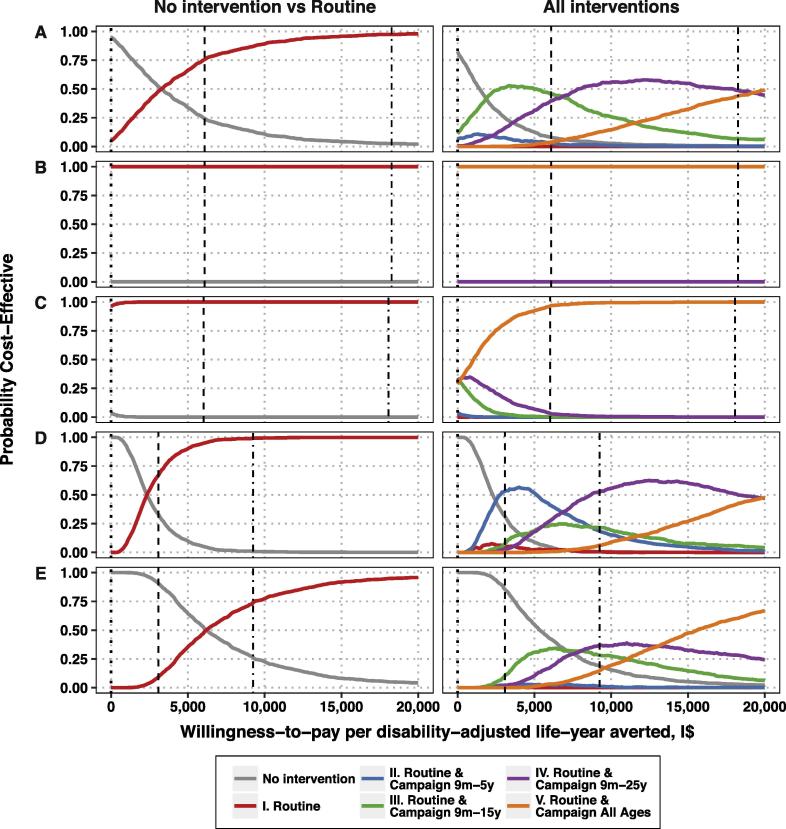
Cost-effectiveness acceptability curves for routine vaccination at 9 months of age (left) and for all five delivery strategies under consideration (right) versus no intervention for (A) Kolkata, (B) Delhi, (C) Dong Thap, (D) Nairobi, and (E) Lwak. The dotted line shows the threshold at which an intervention is considered cost-saving, while the dashed line delineates the threshold at which an intervention is considered very cost-effective and the dot-dashed line delineates the threshold at which an intervention is considered cost-effective by the WHO criteria in each country.